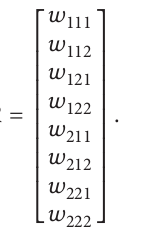
Algorithm 11, under isomorphic conditions in eorem